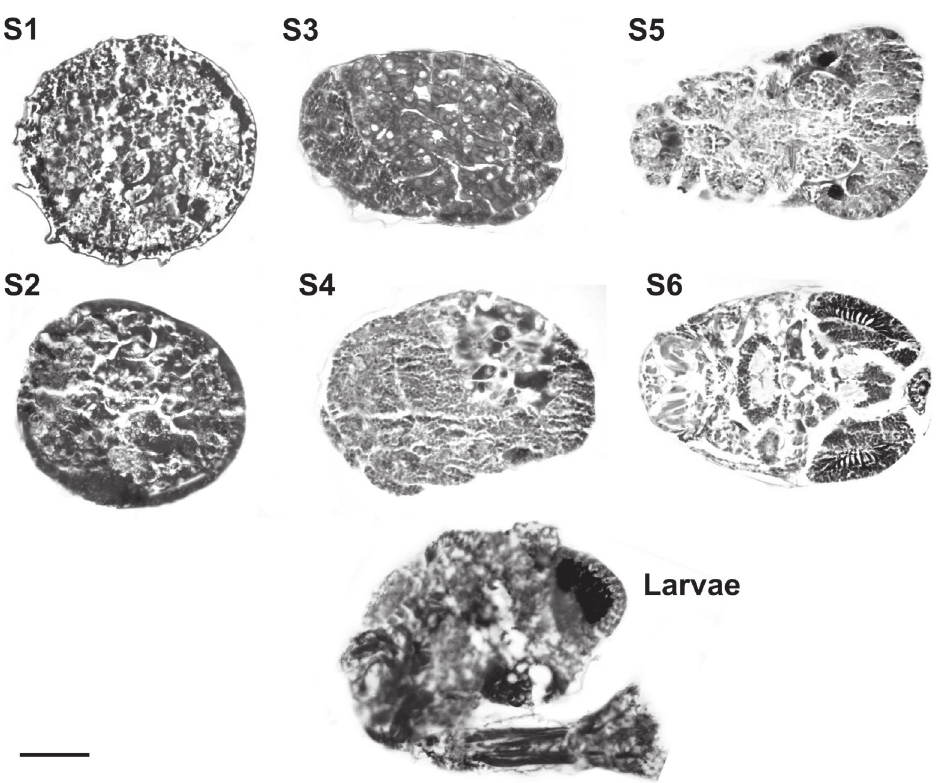
Fig . 2. – sections of eggs with embryos in different development stages. s1: stage 1 (transversal section), s2: stage 2 (frontal section), s3: stage 3 (sagittal section), s4: stage 4 (sagittal section), s5: stage 5 (frontal section), s6: stage 6 (frontal section), Larvae: First larvae just hatched from the egg. bar: 1